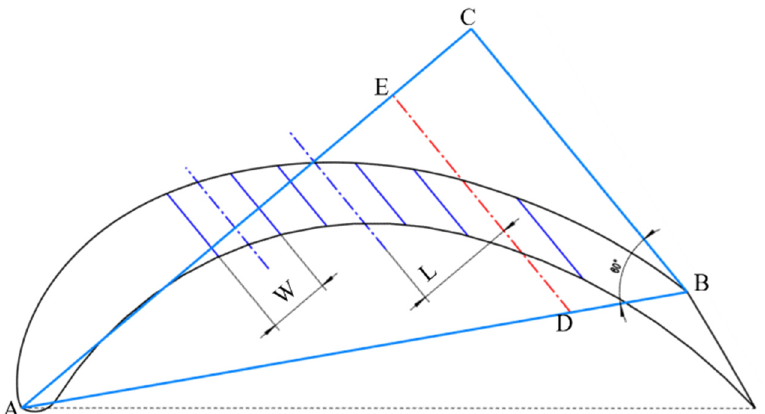
Figure 9. Construction method of bionic groove. Point A at leading edge of blade, point B at trailing edge of blade, point C at the triangle intersect edges, point D at the oblique edge and point E at one of the triangle edge. of the triangle edge.